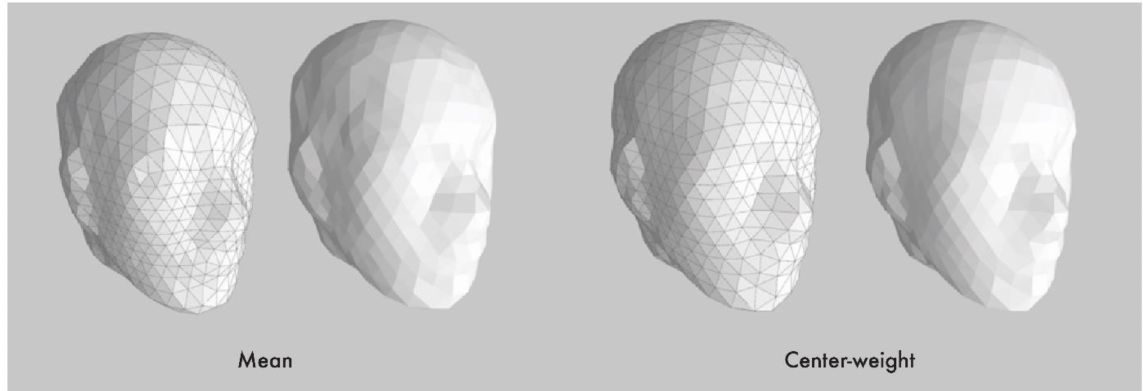
Figure 5. Approach for calculating the length of each actuating pin. The reconstructed model using the mean values of surrounding vertices is shown on the left, and the reconstructed model obtained by setting the weight proportional to the distance of the surrounding vertex value is shown on the